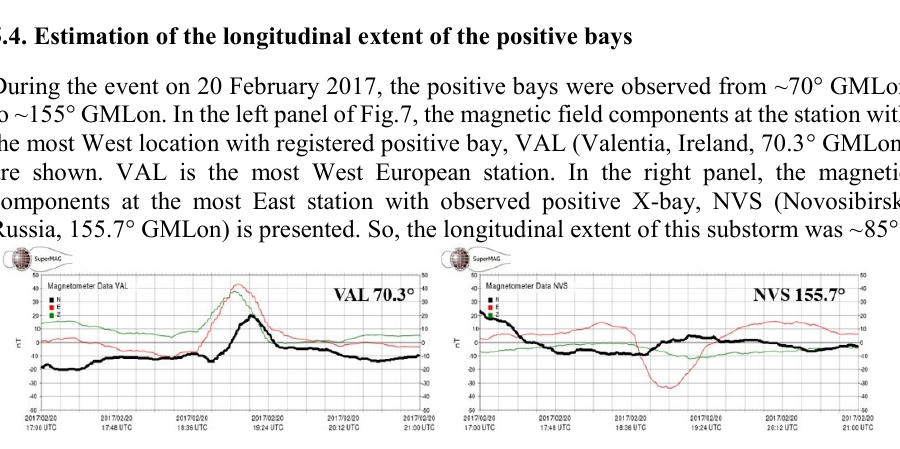
Fig.6. Midlatitude positive bays, observed at the highest geomagnetic latitude (HOV, Faroe Island station, 60.3° GMLat) (left panel) and at the lowest geomagnetic latitude (TAM, Tamanrasset, 8.9° GMLat) (right panel). The X component is drown by a thick